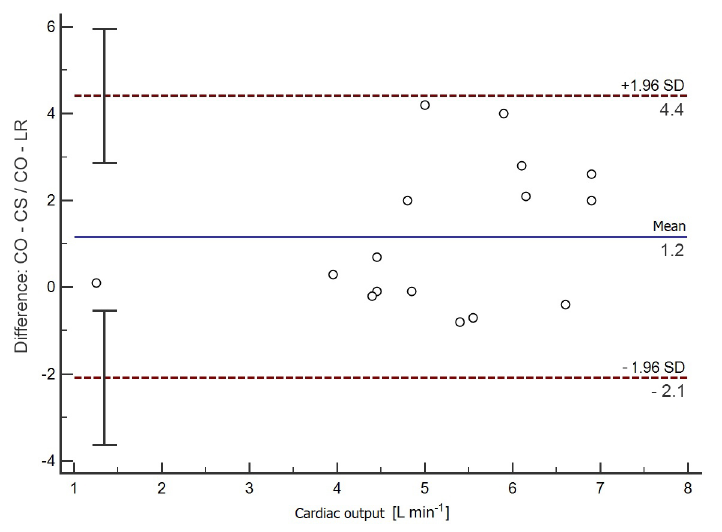
Figure 2. Bland–Altman analysis for the calculated CO-LR and CO-CS values. The solid horizontal line represents the mean value difference between the methods tested. The upper dashed line shows the upper compliance limit value (+1.96 SD). The lower dashed line shows the value of the lower compliance limit ( − 1.96 SD); SD—standard